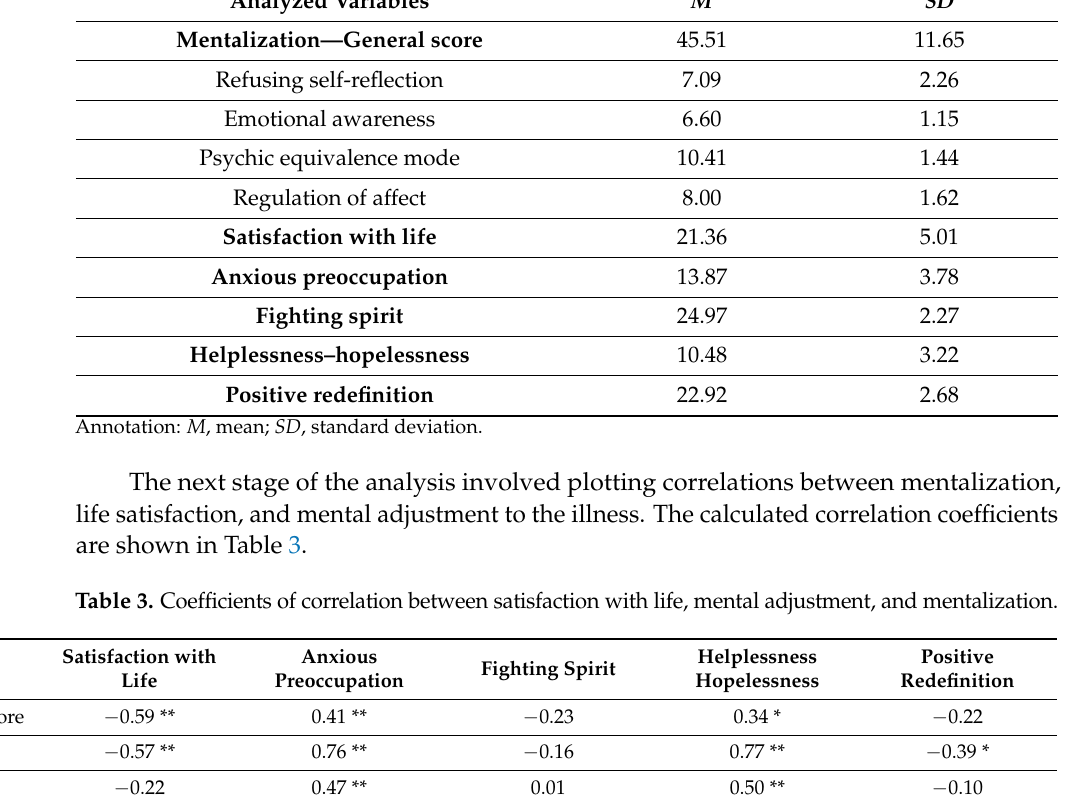
Table 2. Average values and standard deviation of life satisfaction, mental adjustment, and mentalization. Analyzed Variables M